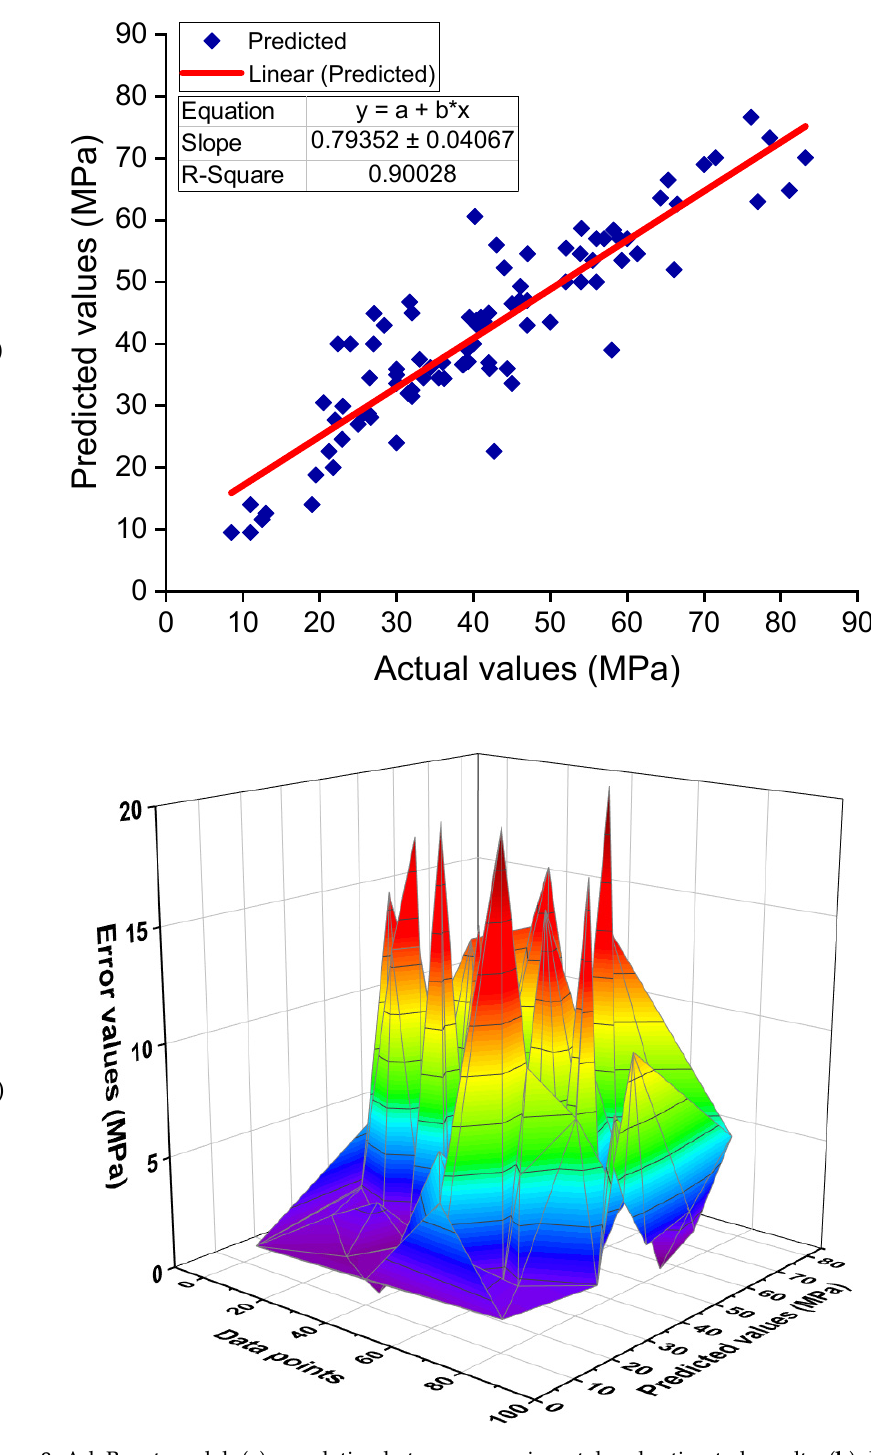
Figure 8. AdaBoost model: ( a ) correlation between experimental and estimated results; ( b ) dispersal of predicted and error values.